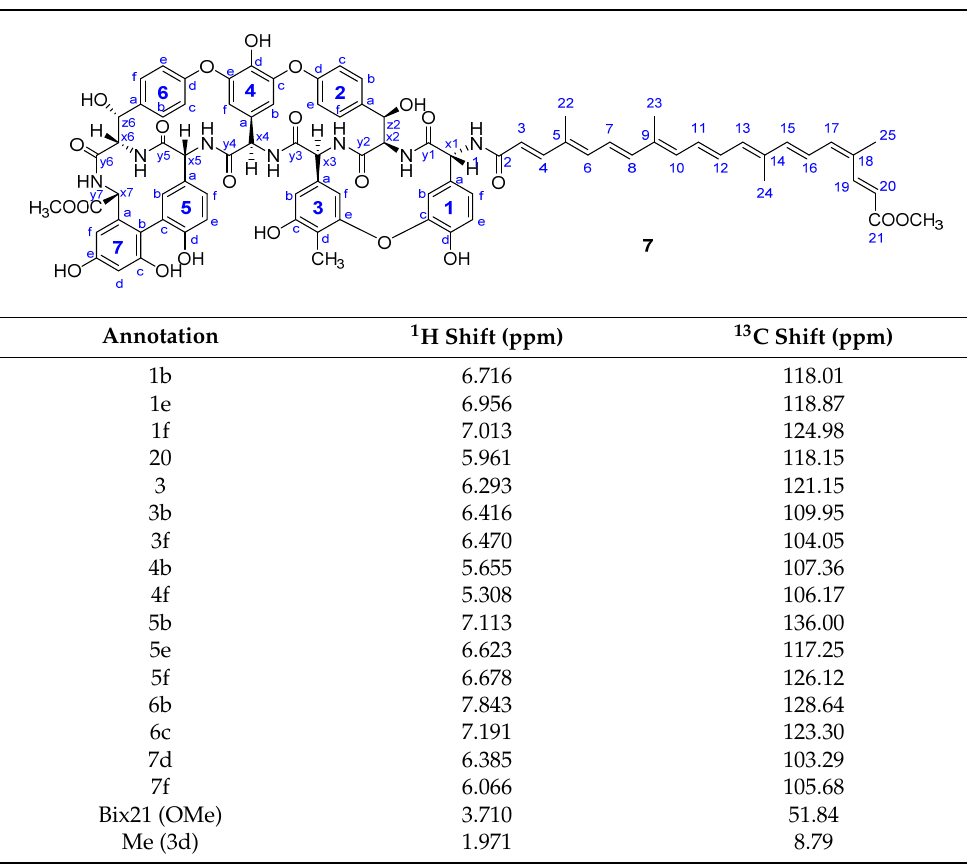
Figure 5. Structure of the two major components of conjugate 6 . Compound 7 : yield 14 mg (18%, HPLC purity 95.7%) red powder; R f = 0.51 (toluene/MeOH 1:1); NMR data of 7 are shown in Table 7. HRMS (MALDI): m/z calcd for C 85 H 79 N 7 O 22 +Na + : 1572.5176 [ M +Na] + ; found: 1572.5670. Table 7. NMR data of 7 .